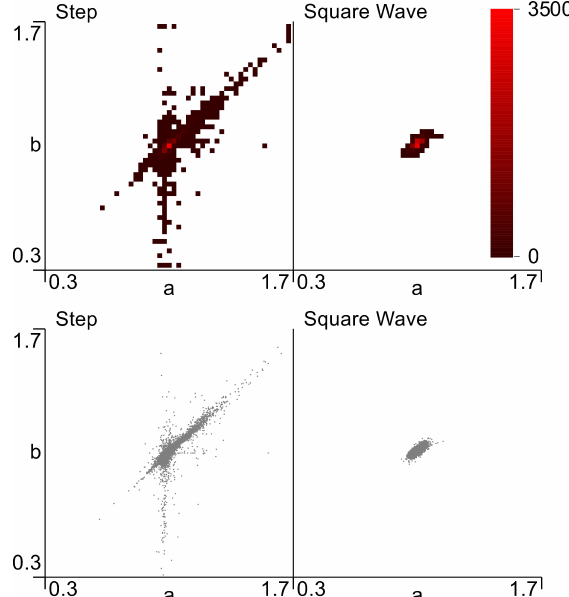
Figure 15: Histogram (top) and scatter plot (bottom) showing how data with poor dynamic in- formation content (left panels, Step data- set) induces outliers in the results. Plots are obtained using Stationary bootstrap with tuning parameter probability p = 0 . 005 and M = 10000